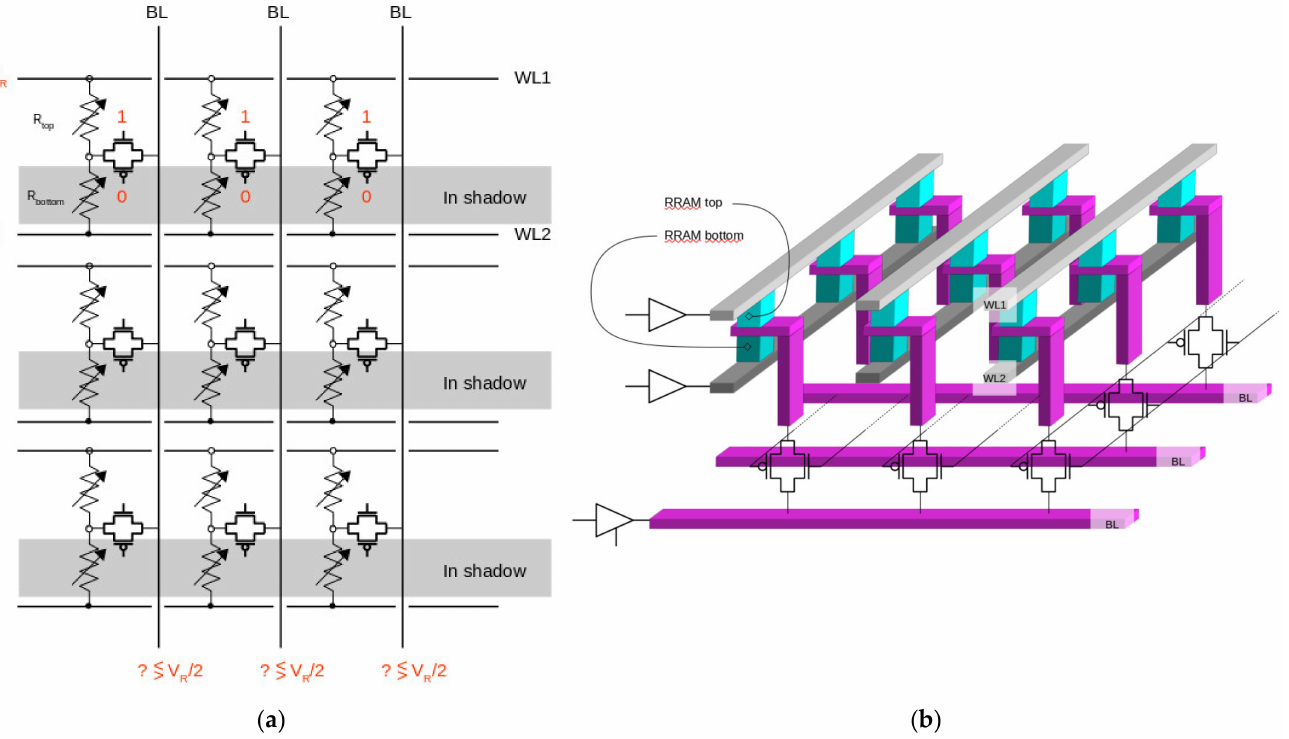
Figure 18. Serial RRAM memory array. ( a ) Schematic distribution of elements. RRAMs (R bottom ) in the shadow area are built under R top RRAMs, so that they become shielded (protected) against physical attacks. ( b ) A 3D view of the